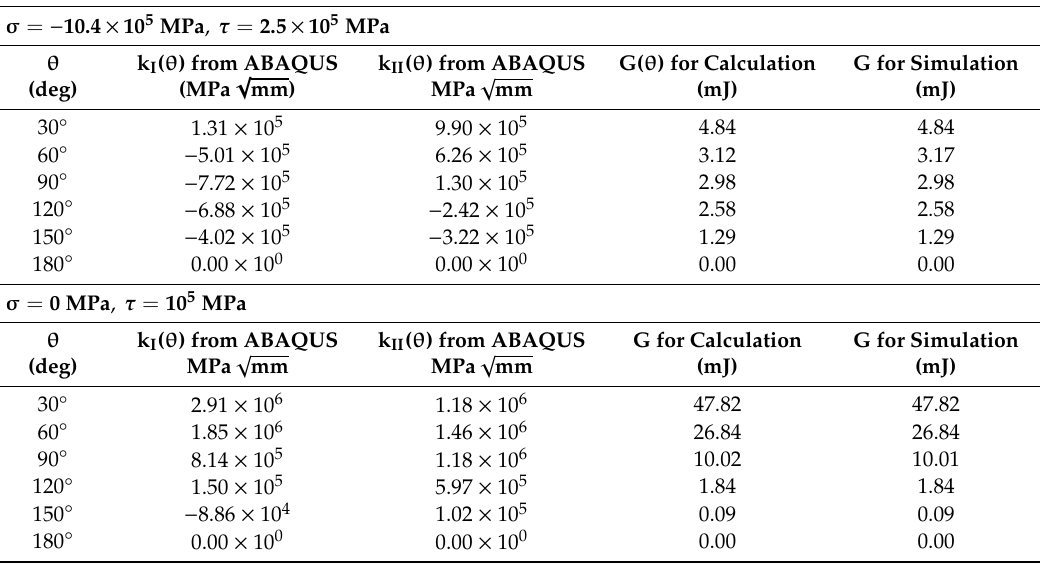
Table 1. Comparison of G for two di ff erent methods.